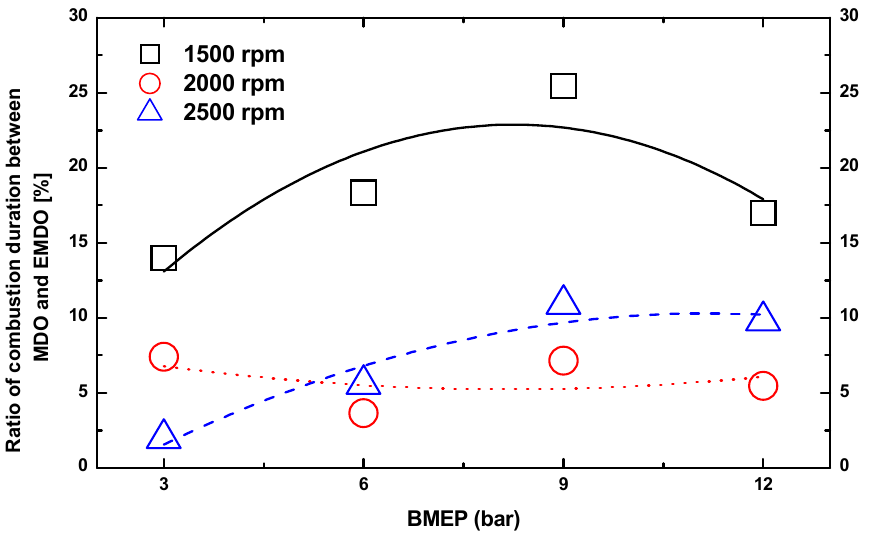
Figure 6. Ratio of combustion duration between marine diesel oil (MDO) and emulsified MDO (EMDO) according to brake mean effective pressure (BMEP) and rpm.